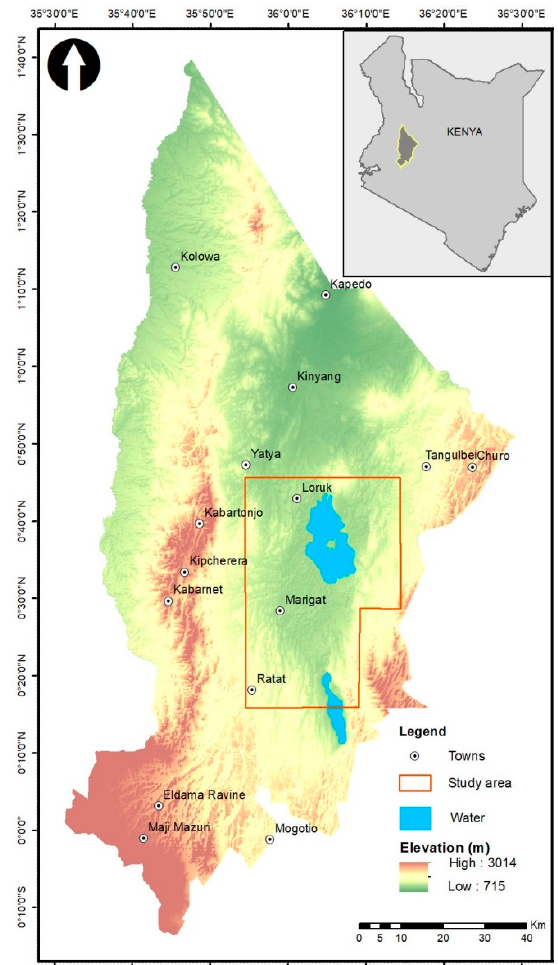
Figure 1. Overview of the study area (red box) covering the Marigat subregion, located in Baringo County, Kenya.